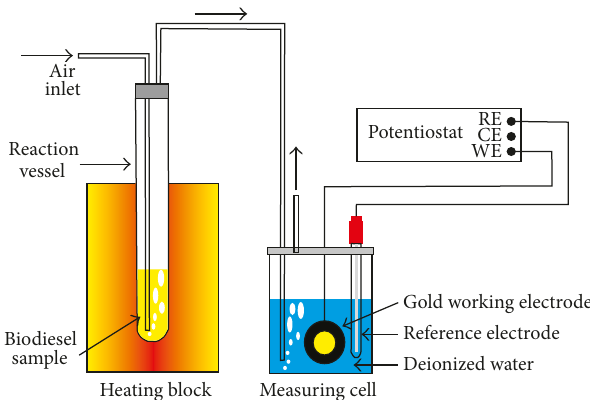
Figure 1: Scheme of the experimental arrangement used to deter- mine the oxidative stability of biodiesel based on OCP measure-